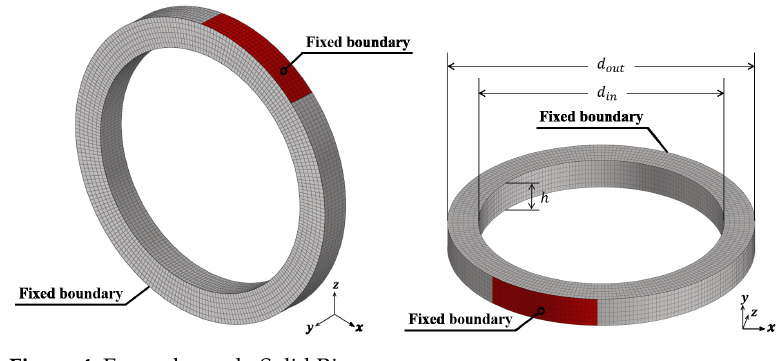
Figure 4. Example mesh, Solid Ring. Table 3. Operation time at each step of the algorithm in the solid ring problem.